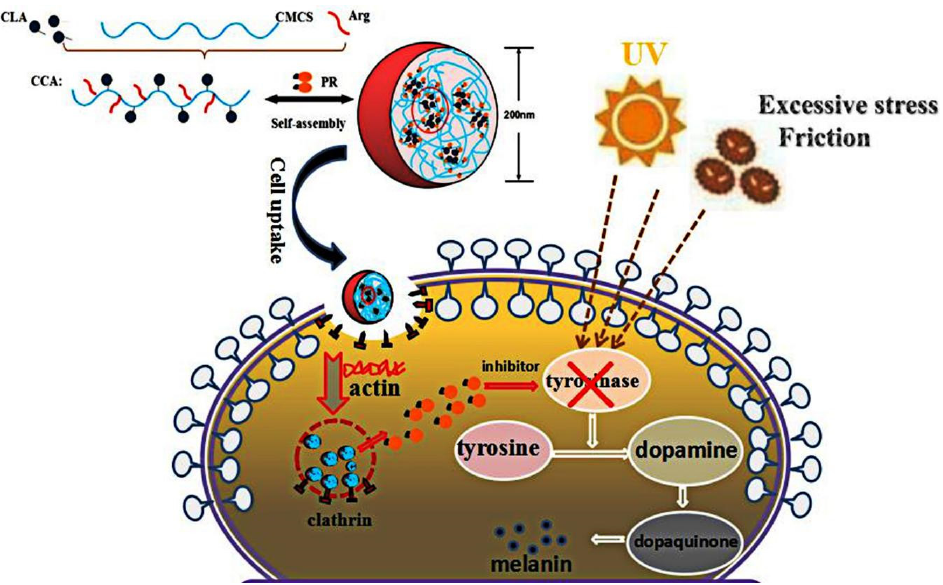
Figure 7. Diagram of self-assembly of CCA5-NPs in distilled water and efficient delivery efficiency of PR in B16 cells.